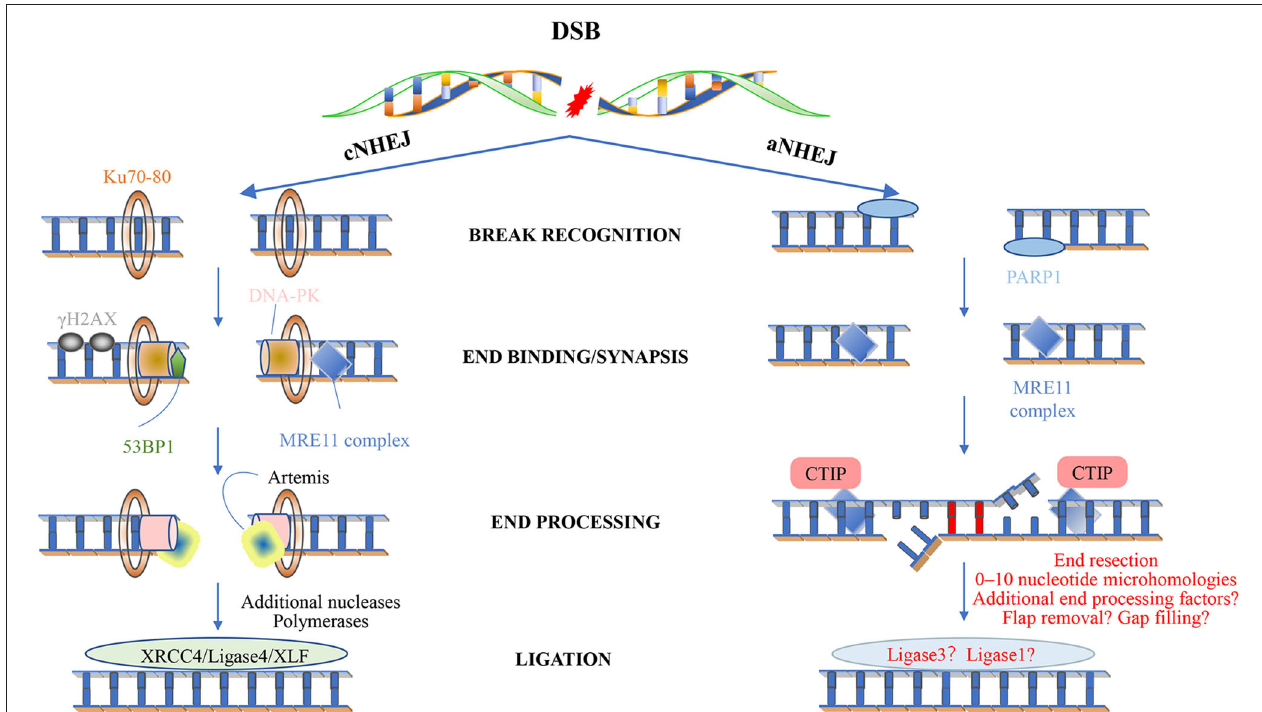
FIGURE 3 | Non-homologous end joining. Classical NHEJ (cNHEJ) is triggered by the binding of a Ku heterodimer to the fragmented DNA end and provides a scaffold for the recruitment of other factors, including DNA-PKC, XRCC4 ligase IV-XLF, Artemis, and DNA polymerase. The Mre11 complex is loaded to the end of the DNA and can recruit ATM. The histone variant H2AX is phosphorylated to form γ -H2AX, which is located on both sides of the fracture. This in turn promotes the recruitment of other factors, leading to the assembly of large multi-protein complexes that may play a role in disrupting the signal, repairing and keeping DNA ends together, and minimizing the chance of abnormal rearrangements. cNHEJ requires additional enzymes to prepare the DNA-attached ends. One of the enzymes is Artemis, and once DNA-PK stimulates the endonuclease activity in Artemis, it will hit the development clamp. The last step of cNHEJ involves binding the DNA ends through the DNA ligase IV/XRCC4/XLF complex. In short, cNHEJ is a repair process in which the ends of DSBs are directly linked by DNA ligase, which does not rely on homologous DNA sequences. The Ku protein (Ku70/Ku80) complex recognizes and binds to the end of DSBs, and the Ku-DNA complex recruits DNA-dependent protein kinase catalytic subunits (DNA-PKcs) to activate its kinase activity, phosphorylate itself to initiate the NHEJ pathway, and attract the recombinase Artemis Join to process the DNA ends, and then summon the XRCC4-DNAligase4-XLF complex to promote the ligation of the DNA ends. Less is known about the mechanism of alternative NHEJ (aNHEJ). Although PARP1 can interact with free DNA ends, is associated with DNA damage induction, and can interact with ATM, the Mre11 complex seems to play an important role. However, the mechanism of its action is still unclear. Recent studies have shown that aNHEJ also occurs in cells that can activate other repair pathways. Future research will definitely learn more about this mechanism and its genome editing